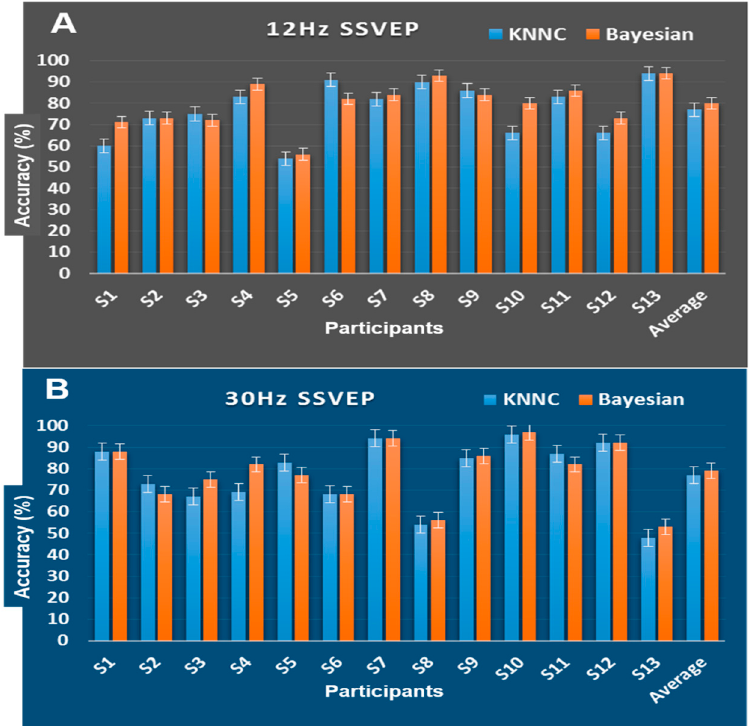
Figure 8. The classification outcomes of the Bayesian network and KNN classifier with SSVEP of 12 Hz and 30 Hz at O1 and O2 (occipital lobe). ( A ) The accuracy (%) of the Bayesian network and KNN classifier using SSVEP of 12 Hz at O1 and O2. ( B ) The accuracy (%) of the Bayesian network and KNN classifier with SSVEP of 30 Hz at O1 and O2.